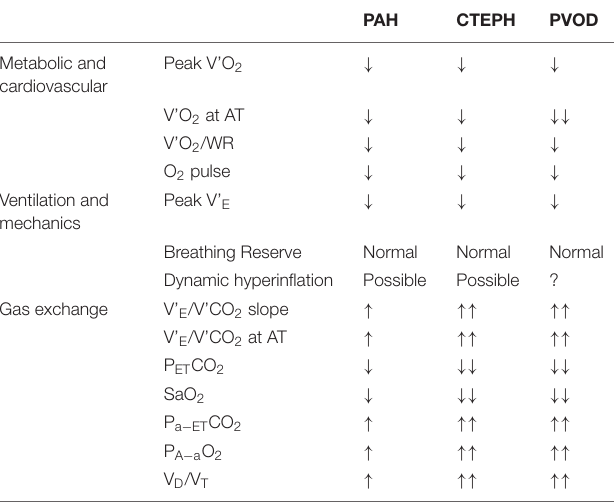
TABLE 2 | Typical CPET anomalies in patients with pulmonary vascular diseases. PAH CTEPH